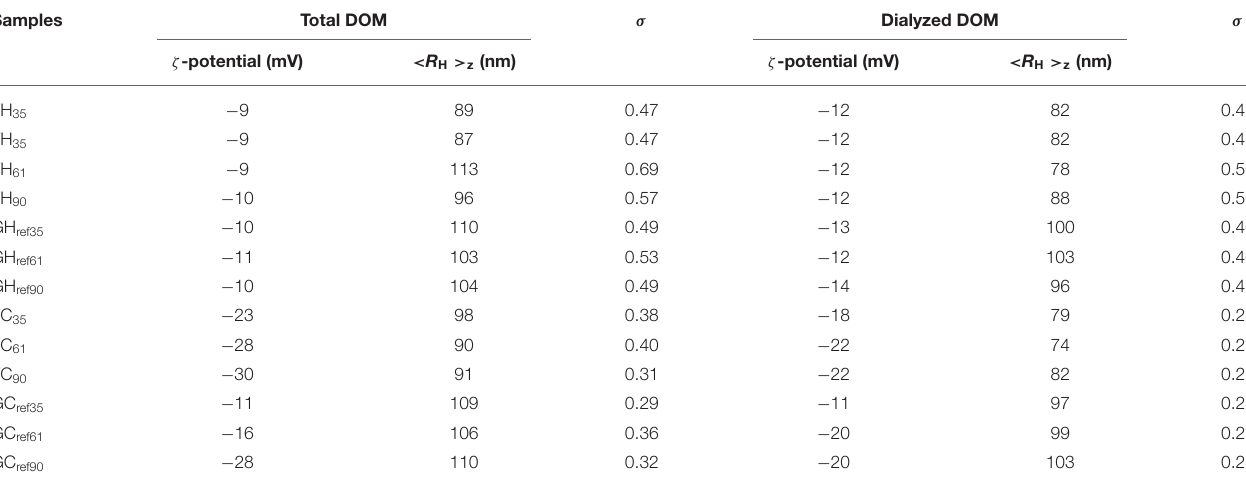
TABLE 3 | Summary of results from DLS and ζ -potential measurements of all DOM samples before and after dialysis. Samples